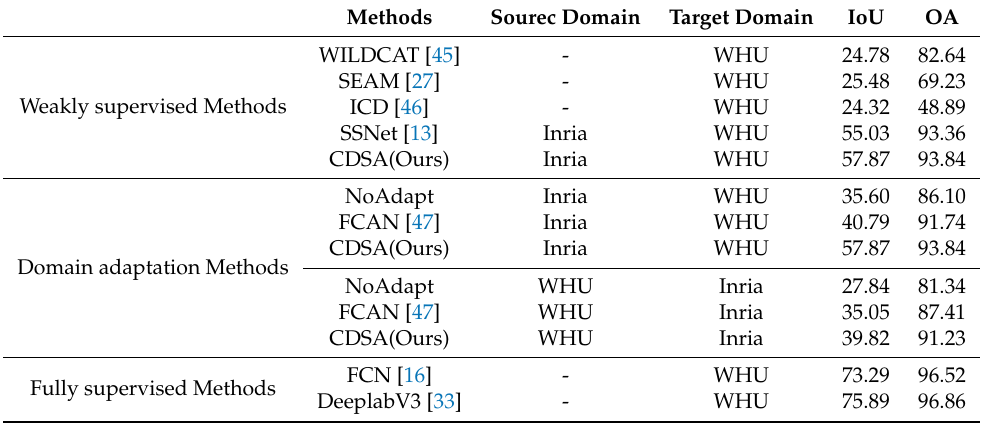
Table 2. Performence Comparisons (IoU AND OA) among Different Methods on the WHU Data Set (%). Methods Sourec Domain Target Domain